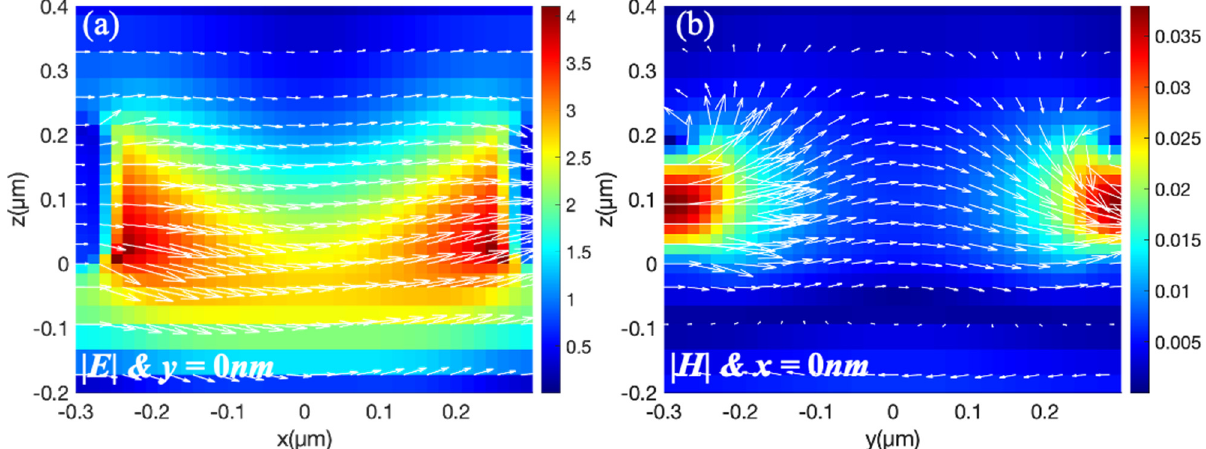
Figure 4. Electric/Magnetic field distributions of the reflection peak marked in Figure 2b: ( a ) Normalized electric field distribution on the x - z plane with y = 0; ( b ) Normalized magnetic field distribution on the y - z plane with x = 0.